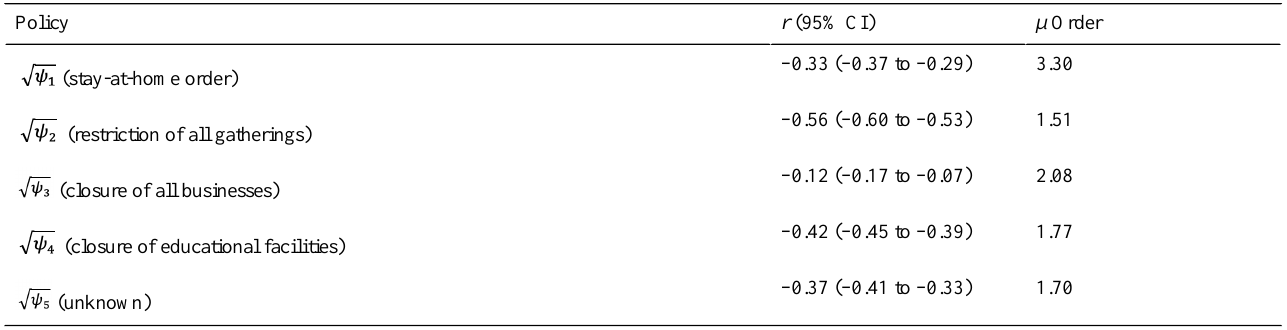
Table 4. Spearman correlations of policy effect sizes with chronological rank order of